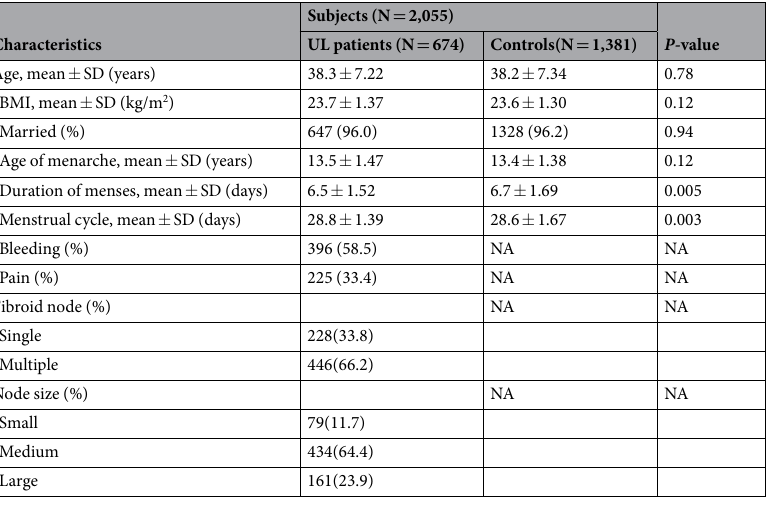
Table 1. The clinical and demographic characteristics of the uterine leiomyoma and control groups. UL: uterine leiomyoma; BMI: body mass index; SD: standard deviation; NA: not